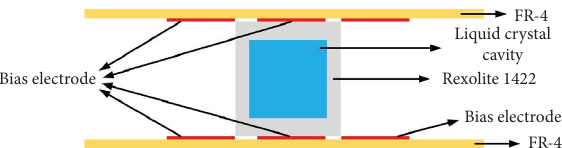
Figure 3: Te schematic diagram of the dielectric phase shifter.